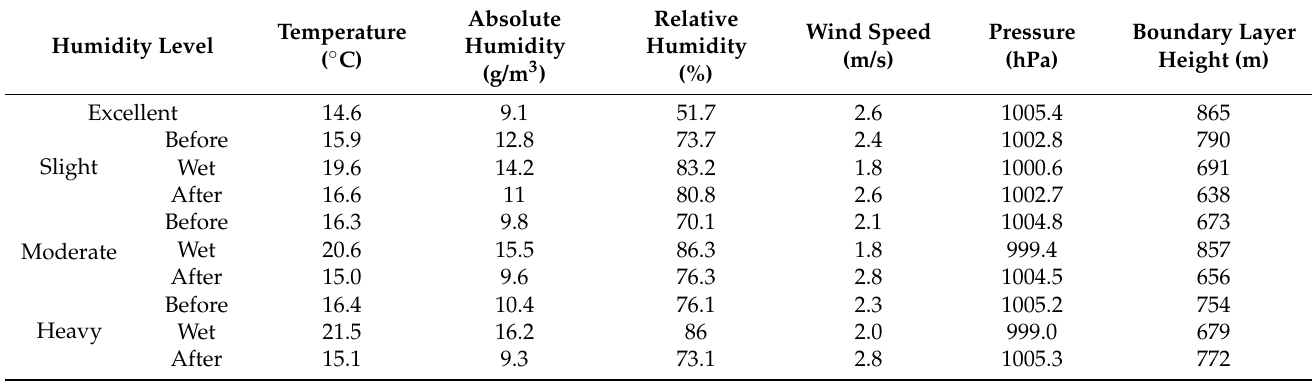
Figure 3. Spatial distribution of meteorological elements under different stages and levels in February and March from 2012 to 2021. ( a – c ) Slight humidity, ( d – f ) moderate humidity, and ( g – i ) heavy humidity; ( a , d , g ) before-stage, ( b , e , h ) wet-stage, and ( c , f , i ) after-stage. Table 2. Variation in the daily average meteorological parameters in different stages and humidity levels.